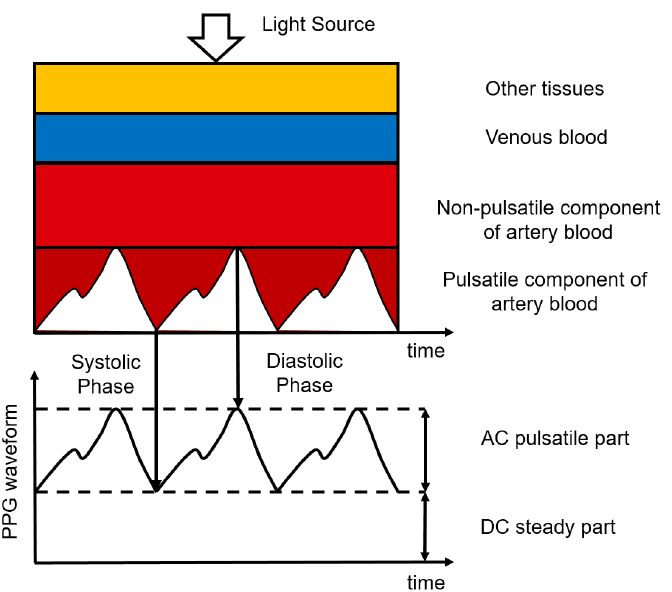
Figure 4. Composition of the PPG signal where different tissue layers cause the absorption of light. Figure reproduced from